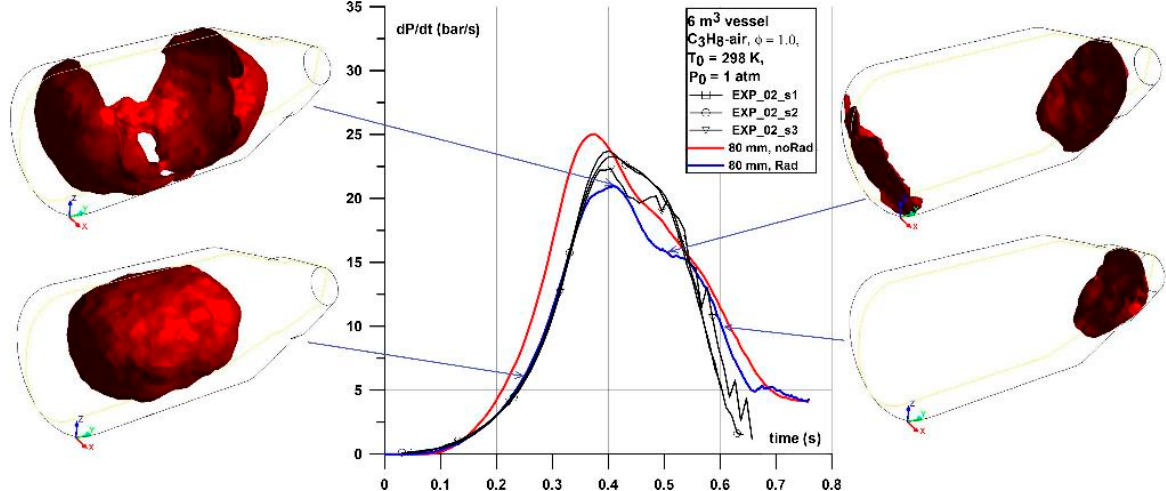
Figure 18. Flame front positions in the 6 m 3 vessel at various simulation times. C 3 H 8 –air mixture.